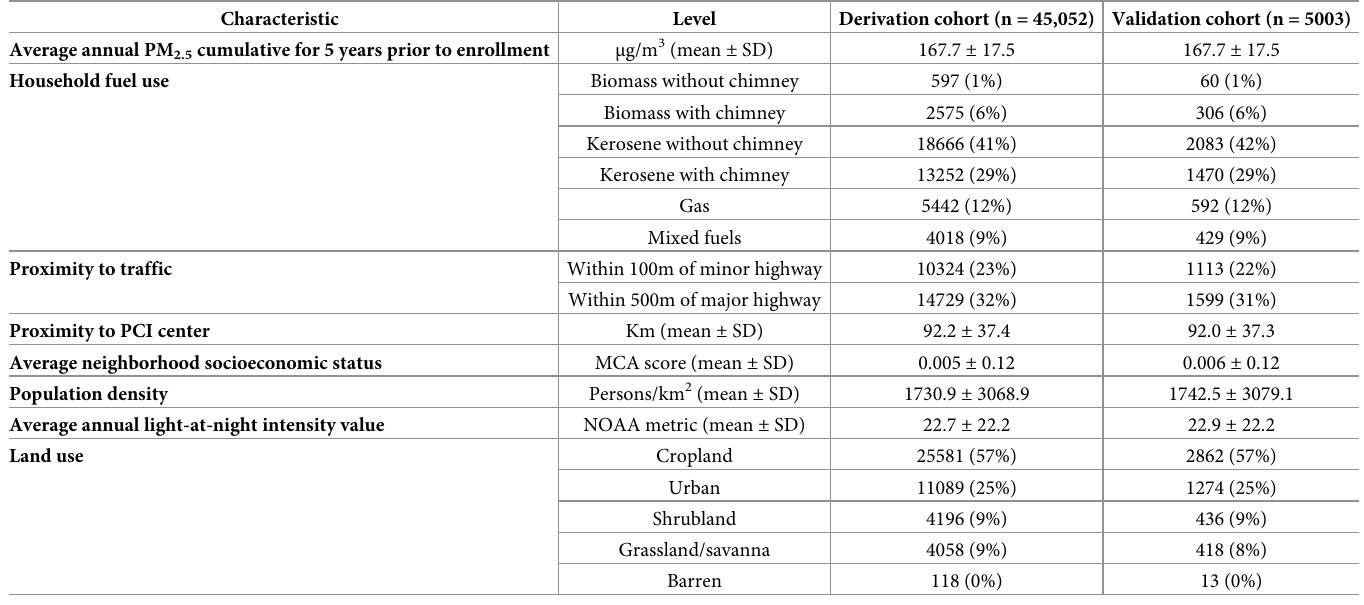
Table 2. Individual exposures to spatial environmental